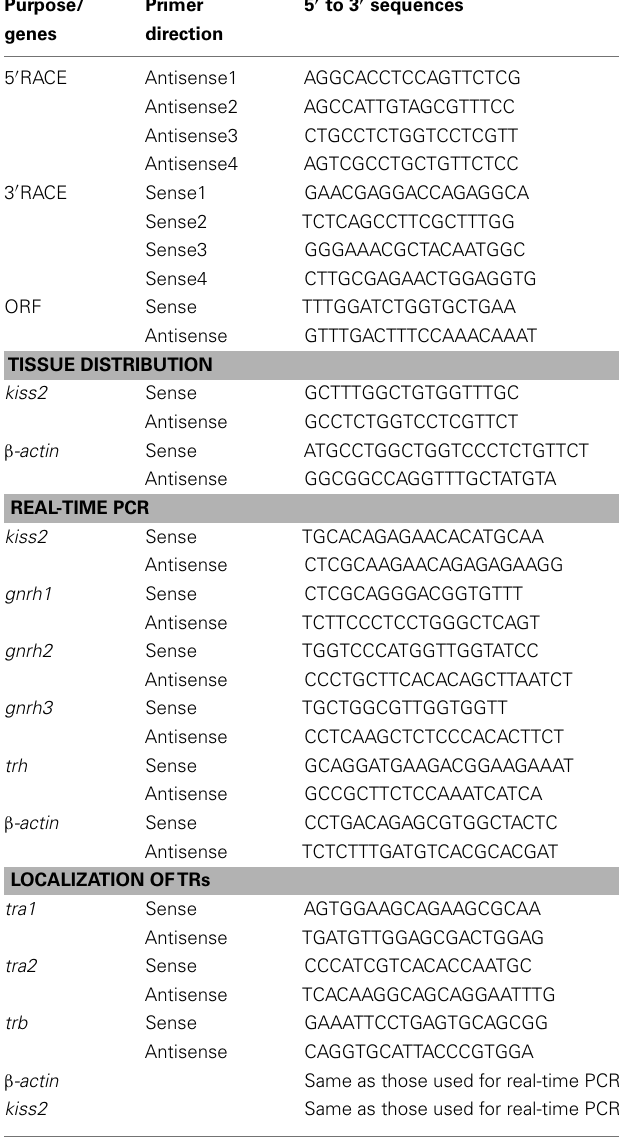
Table 1 | Primers for tilapia genes used in present